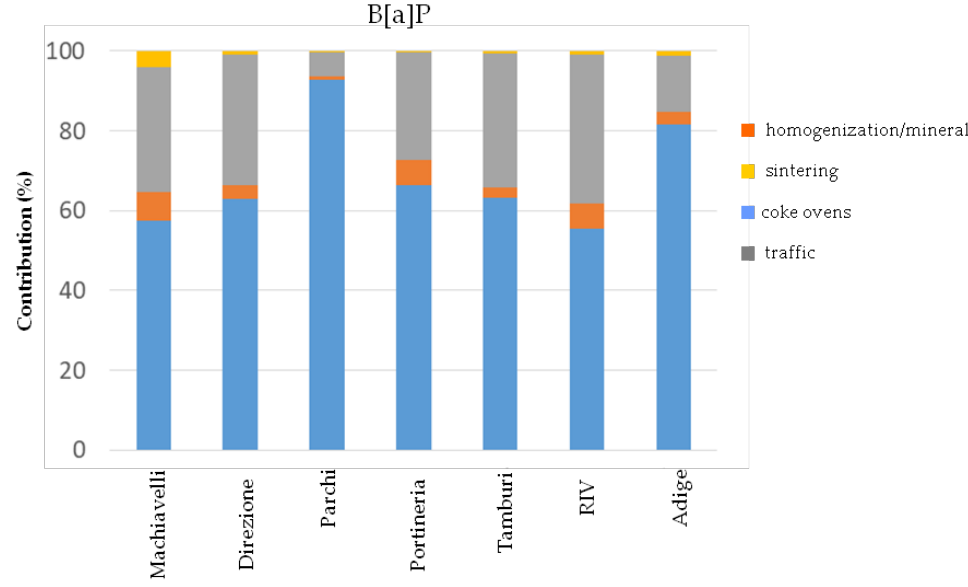
Figure 5. Percentage contribution of factors on B[a]P concentrations at the receptor sites.